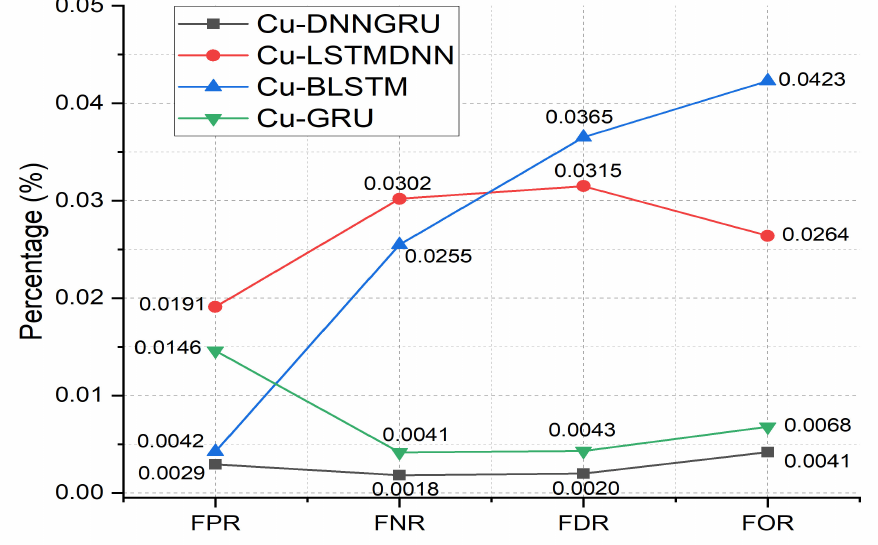
Figure 6. FPR, FNR, FDR, and FOR analysis.